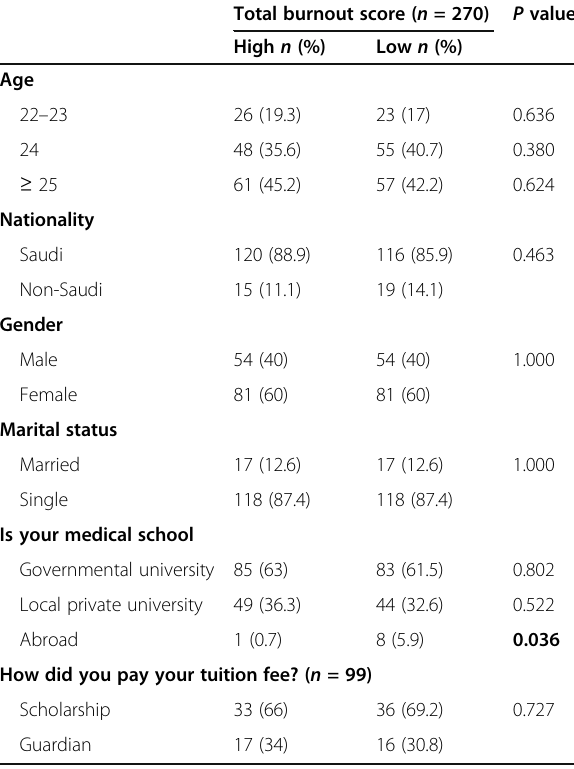
Table 7 Factors related to total burnout score Table 8 Factors related to unethical